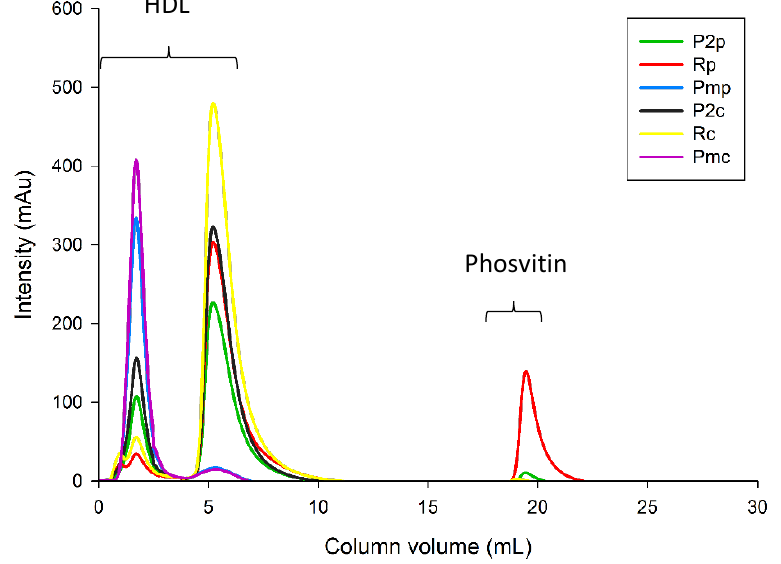
Figure 4. Chromatograms obtained by fast protein liquid chromatography (FPLC) for control and pressure-treated plasma, retentate and permeate fractions. P2 C : control plasma, P2 P : plasma from